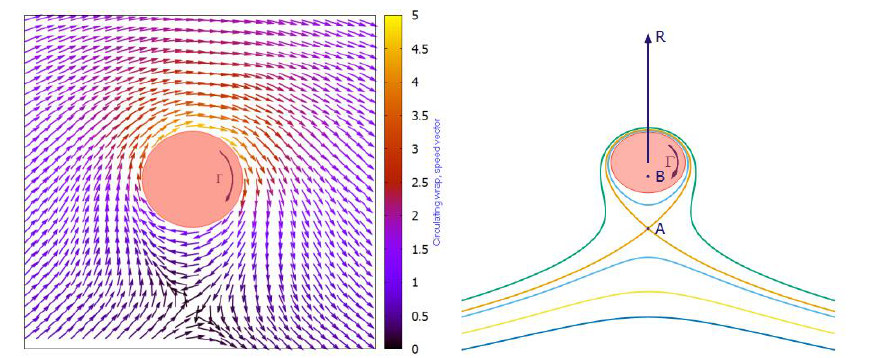
Fig. 6. The velocity field of a plane flow of an ideal fluid (left) and a streamline (right) in the case of a circulation flow around a circular cylinder at .